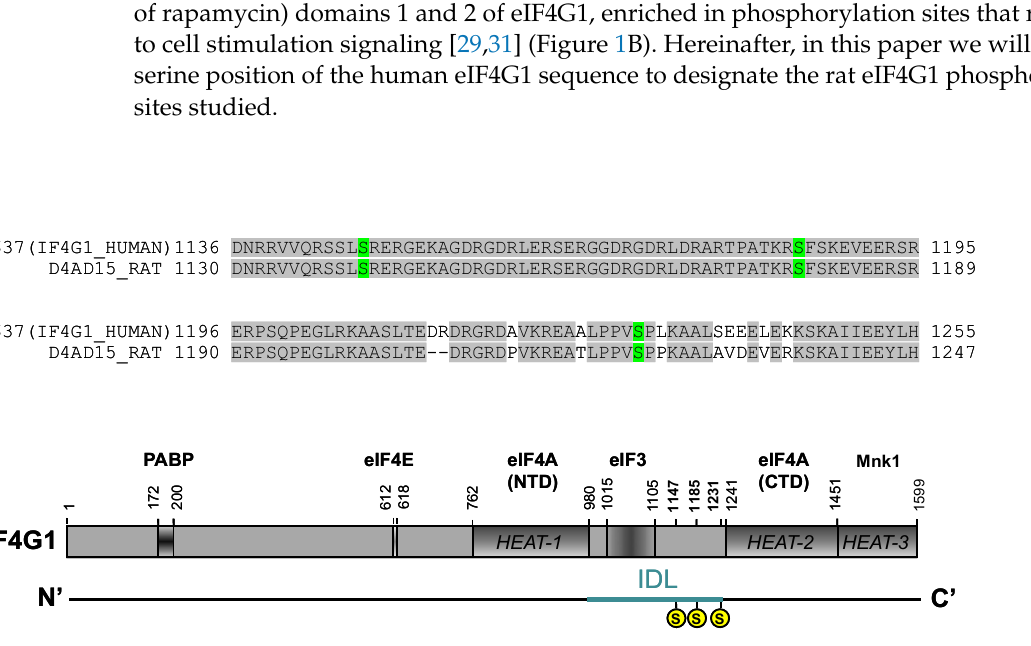
Figure 1. Phosphorylation sites in eIF4G1 sequence. ( A ) Alignment of human and rat eIF4G1 sequences in the region of the phosphorylation sites studied in this work. Amino acid positions with homology between human and rat are shaded in grey and serine phospho-sites studied are marked in green. ( B ) eIF4G1 protein domains. Serine phospho-sites studied are marked in yellow in the interdomain linker (IDL) region. Labels of initiation factors (eIFs) and other proteins indicate the binding region to eIF4G1.